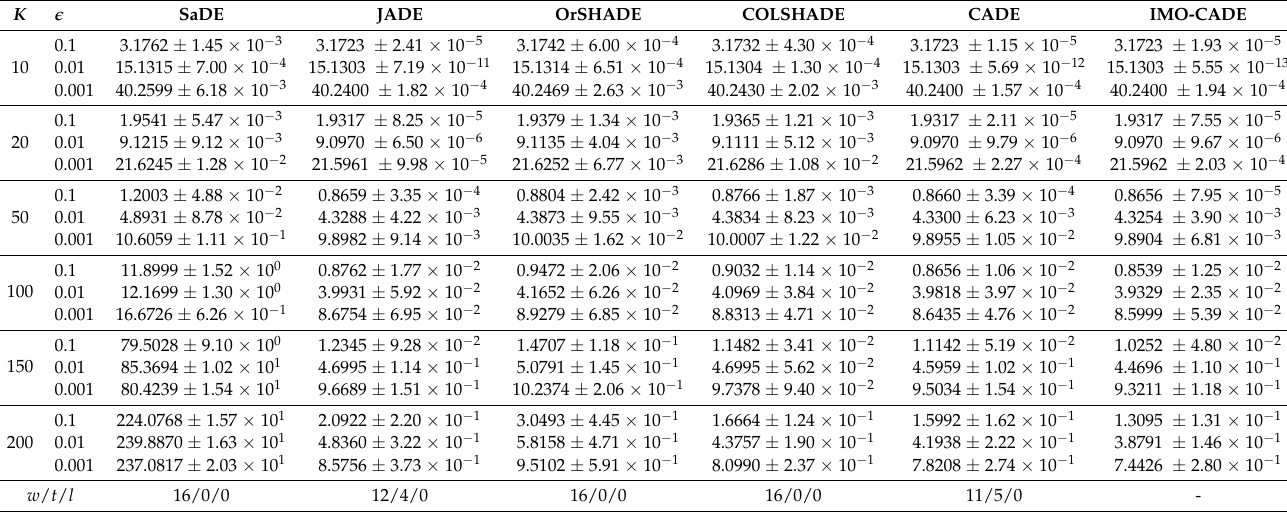
Figure 2. Average rankings of different DE variants obtained by the Friedman test for the OPA with i.i.d. observations, where the p -value computed by Iman and Daveport test is 0. Table 1. Comparison of different DE variants for the OPA with different sensor nodes under i.i.d. observations.